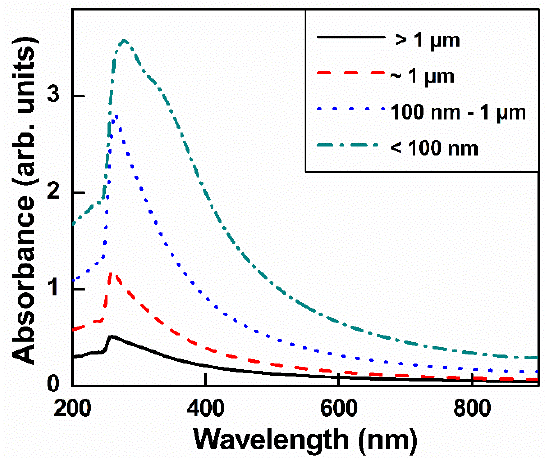
ff erent sizes in aqueous Figure 3. UV-visible spectra of GO with different sizes in aqueous solution. Figure 3. UV-visible spectra of GO with di Figure 3. UV-visible spectra of GO with different sizes in aqueous solution.